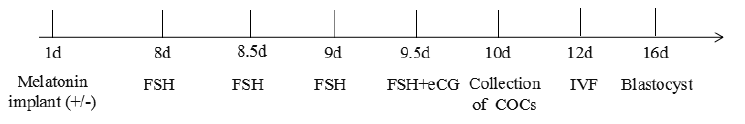
Figure A1. Superovulation scheme ( n =